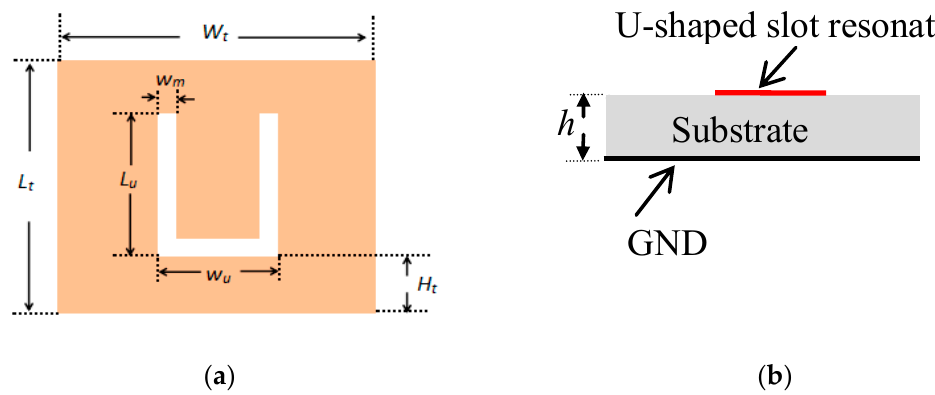
Figure 3. Structure of U-shaped resonators chipless tag: ( a ) Top view; ( b ) Side view. 3. Design and Simulation of the Chipless Tag for U-Shaped Slot Resonators Multiple side-by-side U-shaped slot resonators placed parallel to each other are etched on the microstrip line to form a multi-bit chipless tag, visible in Figure 4, where the L 1 is the width of the microstrip line, W 1 is the length of the microstrip line, L is the length of the shortest U-shaped slot resonator, and m is the side length difference between adjacent U-shaped slots. w is the slot width of the U-shaped slot resonator, and all U-shaped slot resonators have the same slot width. g is the length of the bottom side of the U-shaped slot resonator and is fixed and consistent with the length of the microstrip line. The distance between adjacent U-shaped slot resonators is b . Different resonance frequencies can be obtained by changing the length of a U-shaped slot resonator. A trapezoidal microstrip is used as a transition belt for impedance matching between the microstrip transmission line and the 50-ohm feeder, which plays the role of a gradual transition to impedance, and the reflection will be suppressed.